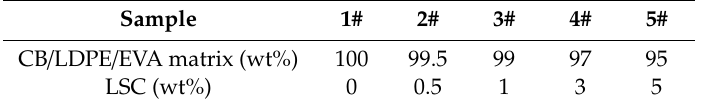
Table 1. Sample notation and